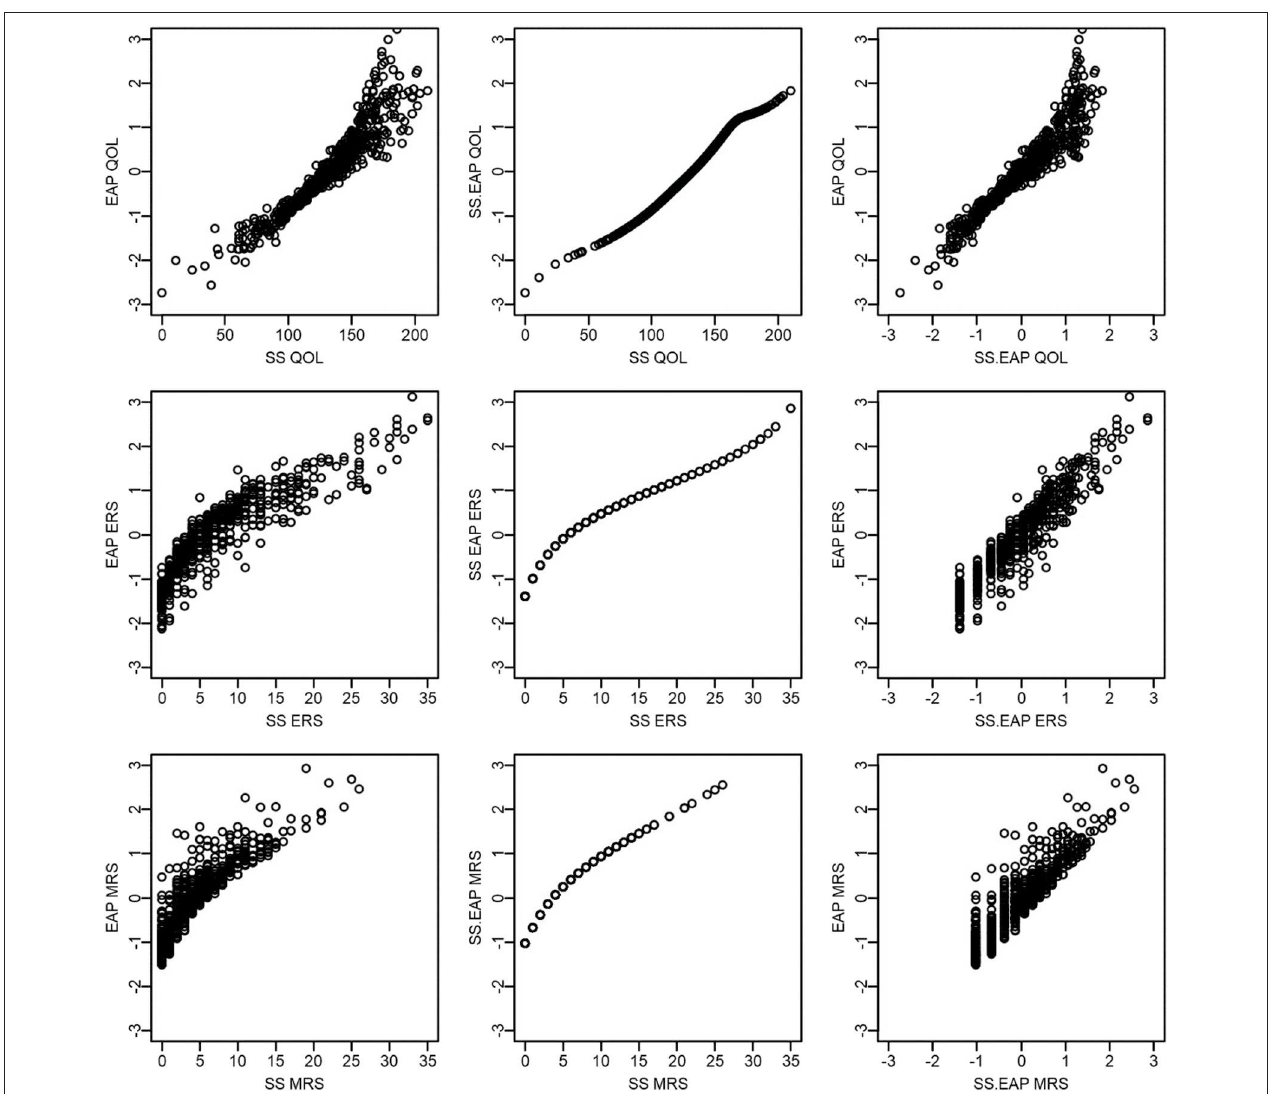
FIGURE 5 | Scatter plots of QOL, ERS, and MRS scores across scoring